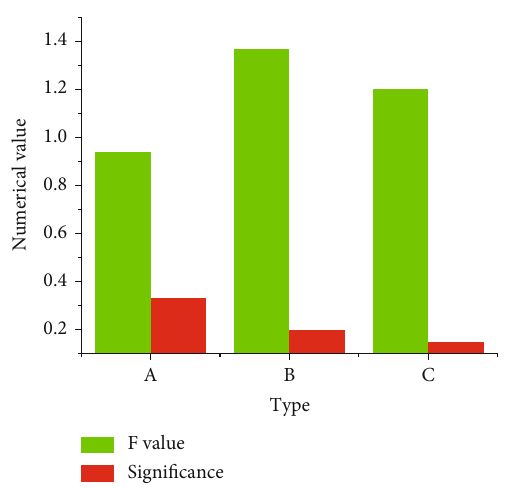
Figure 8: The results of variance analysis of the employees ’ posts (A: grassroots workers; B: middle-level managers; and C: top